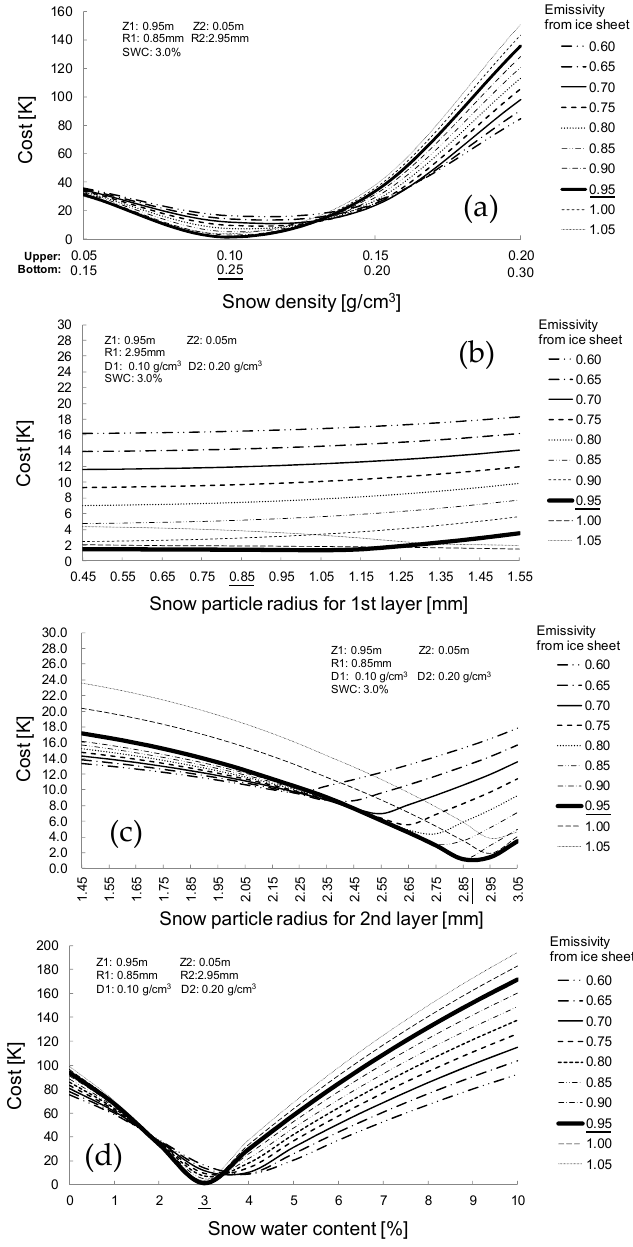
Figure 5. Comparison of costs for various values of snow density, snow particle radius, and snow water content over the wide satellite footprint covering the QH3 site: ( a ) snow density, ( b ) snow particle radius for the upper layer (R1), ( c ) snow particle radius for the bottom layer (R2), and ( d ) snow water content (SWC).